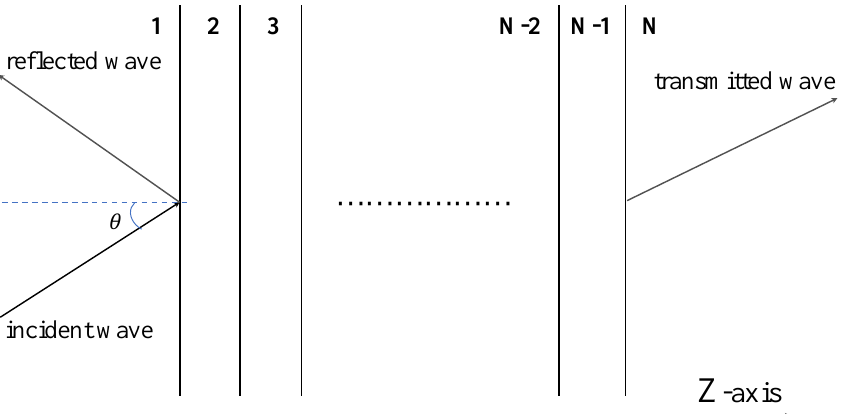
Figure 2. Multi-layer model configuration for the calculation of reflected light intensity. For the n th medium layer, the thickness, dielectric constant, and permeability are defined as d n , ε n , and µ n . The tangential fields at the first boundary ( Z = Z 1 = 0) and the final boundary ( Z = Z N − 1 ) are related by the relation of Equation